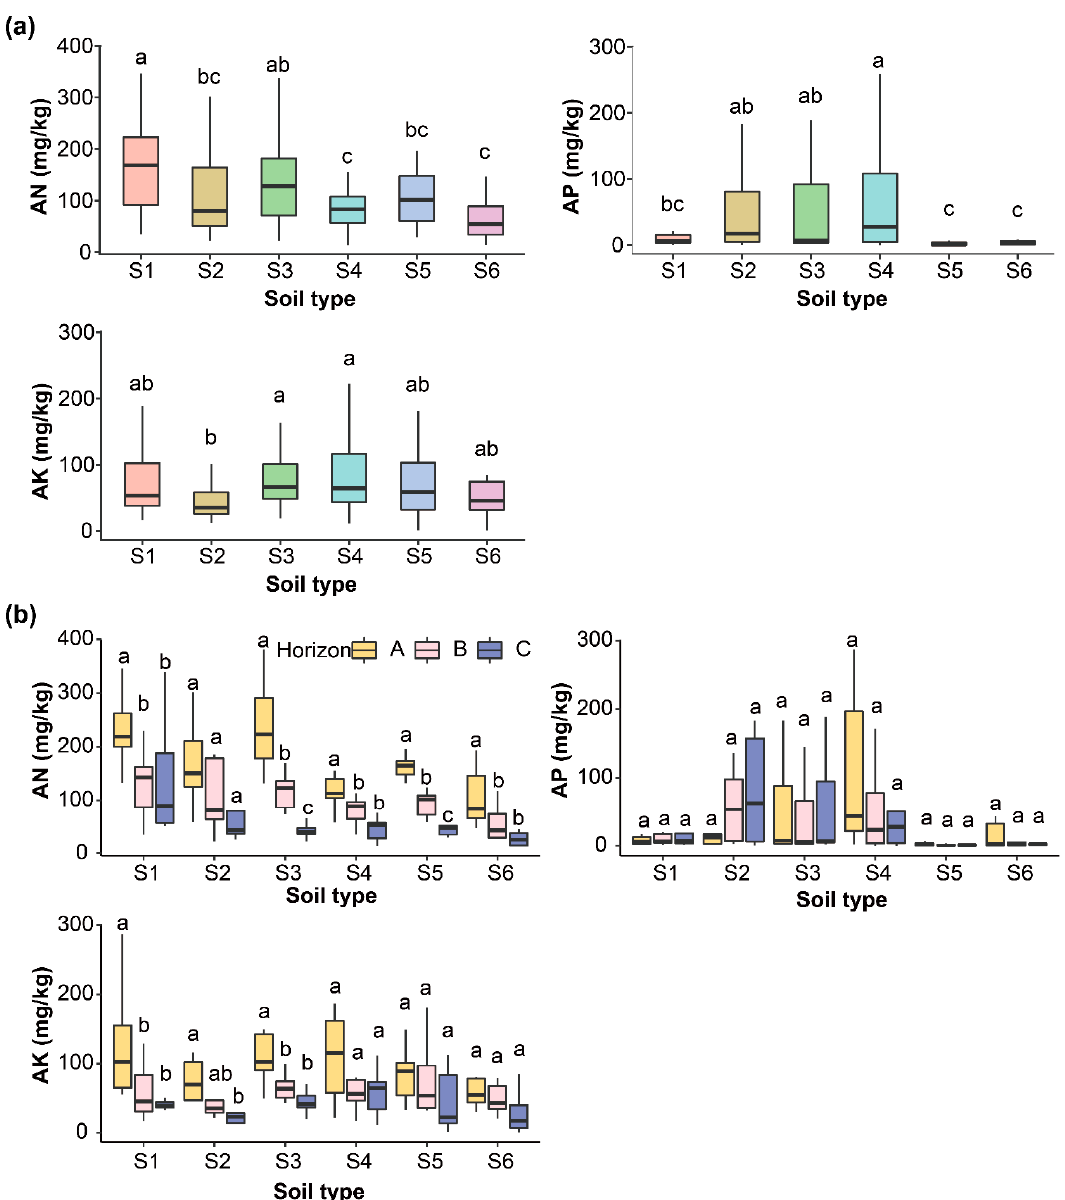
Figure 2. Variance analysis of soil-available nitrogen (AN), soil-available phosphorus (AP), and soil-available potassium (AK) in 6 soil types (subalpine meadow soil, S1; meadow soil, S2; dark brown soil, S3; brown soil, S4; yellow-brown soil, S5; and cinnamon soil, S6). The different lowercase letters indicate significant differences in ( a ) at p < 0.05 by LSD test among 6 soil types, and the same letters indicate no significant differences at p < 0.05 by LSD test among 6 soil types. The different lowercase letters indicate significant differences in ( b ) at p < 0.05 by LSD test among 3 horizons (leaching horizon, A; sediment horizon, B; and parent material horizon, C) in the same soil types, and the same letters indicate no significant differences at p < 0.05 by LSD test among 3 horizons in the same soil types.